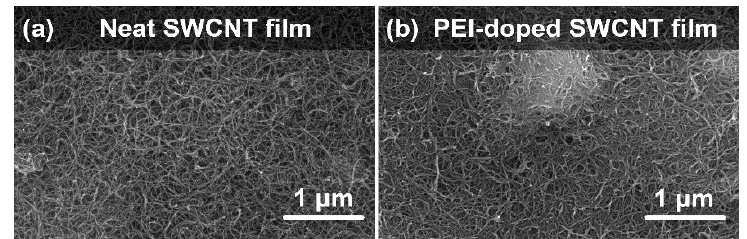
Figure 2. SEM micrographs of ( a ) neat and ( b ) PEI-doped SWCNT free-standing films. Upon doping with PEI, the microstructure of the SWCNT films stayed mostly intact.